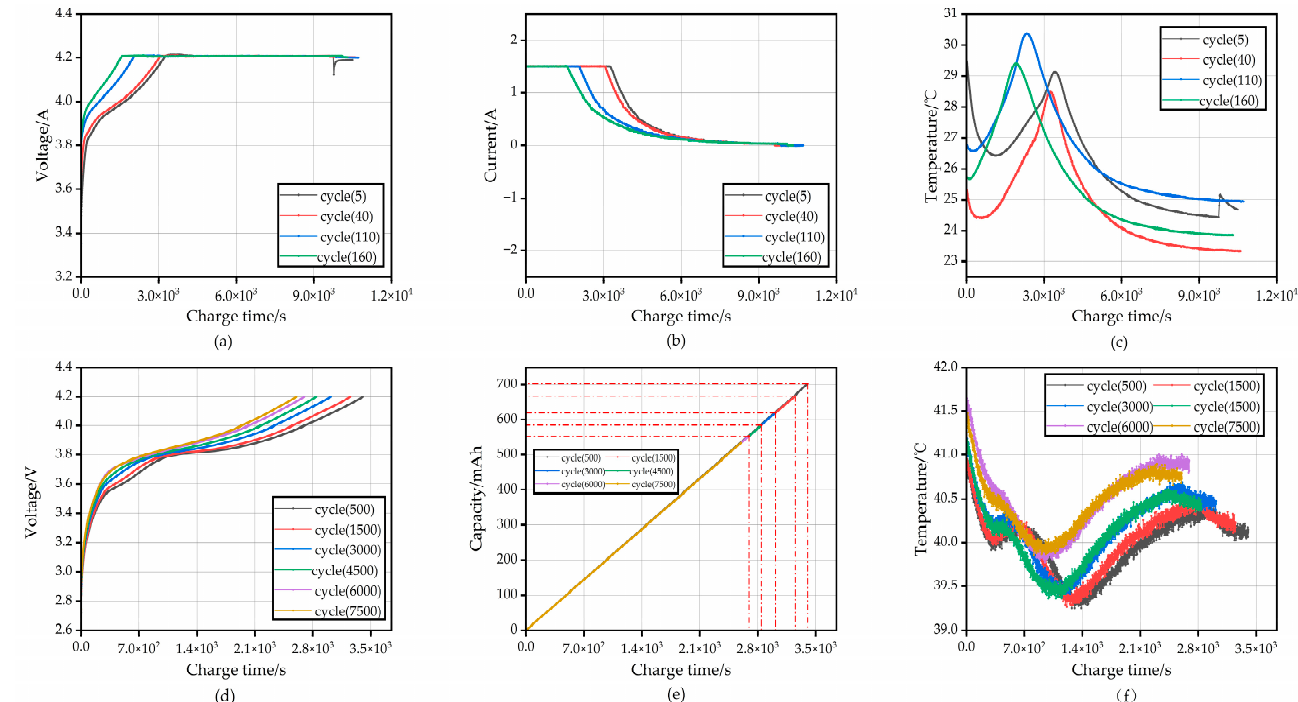
Figure 2. The charging curves of different cycles: ( a ) The voltage curves of B0006; ( b ) The current curves of B0006; ( c ) The temperature curves of B0006; ( d ) The voltage curves of Cell 1; ( e ) The capacity of Cell 1; ( f ) The temperature curves of Cell 1.